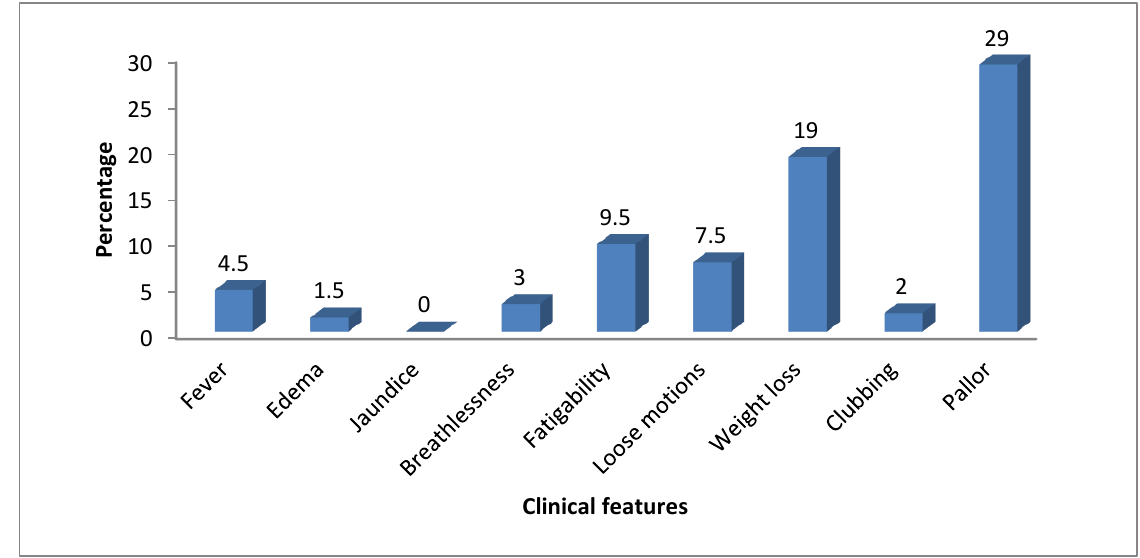
Fig. 1. Distribution according to clinical features.